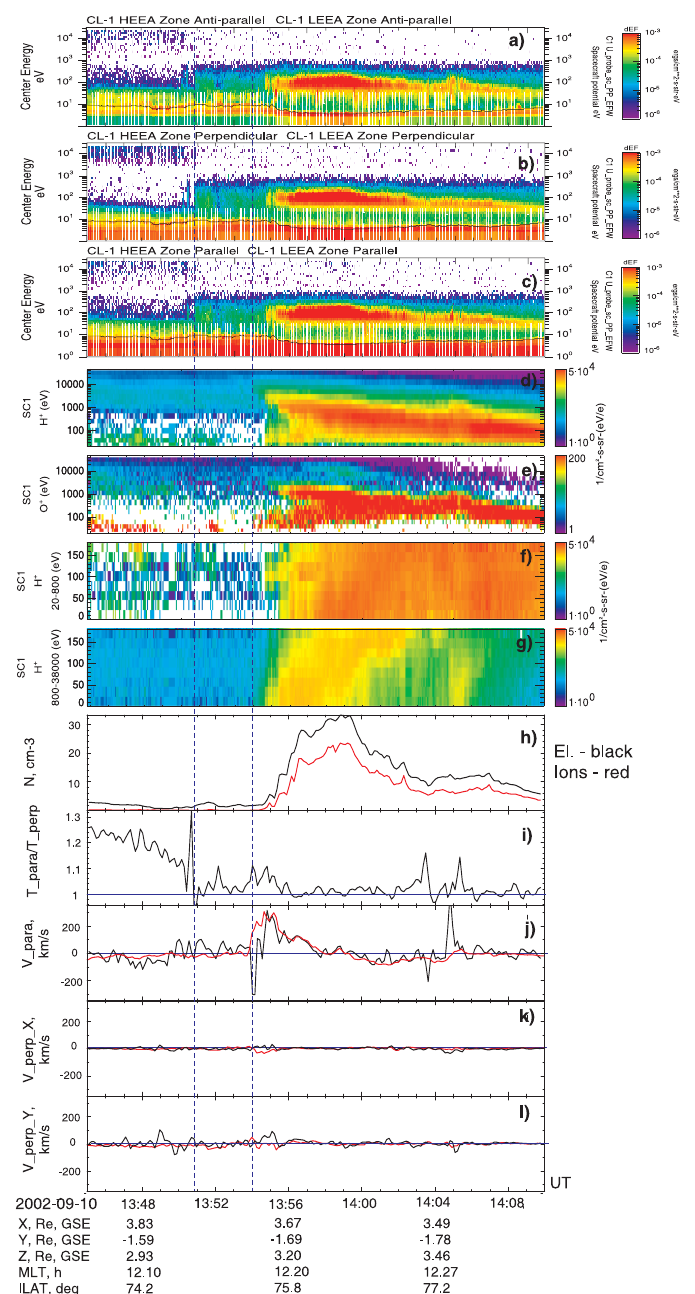
Fig. 3. PEACE and CIS data for the mid-altitude cusp crossing with the prominent electron edge of the LLBL on 10 September 2002, 13:45– 14:10 UT. From top to the bottom: electron energy-time spectrograms in the antiparallel (panel a ), perpendicular (panel b ) and parallel (panel c ) directions; the energy-time spectrogram of protons H + (panel d ); the energy-time spectrogram of oxygen O + ions (panel e ); the pitch-angle (0 ◦ –180 ◦ )-time spectrograms for low-energy (20 <E< 800eV) and high-energy (0.8 <E< 38keV) protons (panels f and g , respectively); the electron (black trace) and the ion (red trace) density (panel h ); the electron anisotropy, defined as T k / T ⊥ , (panel i ); the parallel velocity of plasma (panel j ) and X- and Y-components of the perpendicular plasma velocity (panels k and l ). Black traces correspond to electron data and red traces correspond to ion data, and plasma velocities are shown in the same scale for inter-comparison. The ephemeris data for SC1 are presented under the plot: X-, Y-, Z-components of position in the GSE coordinate system, magnetic local time (MLT) and invariant latitude (ILAT) of